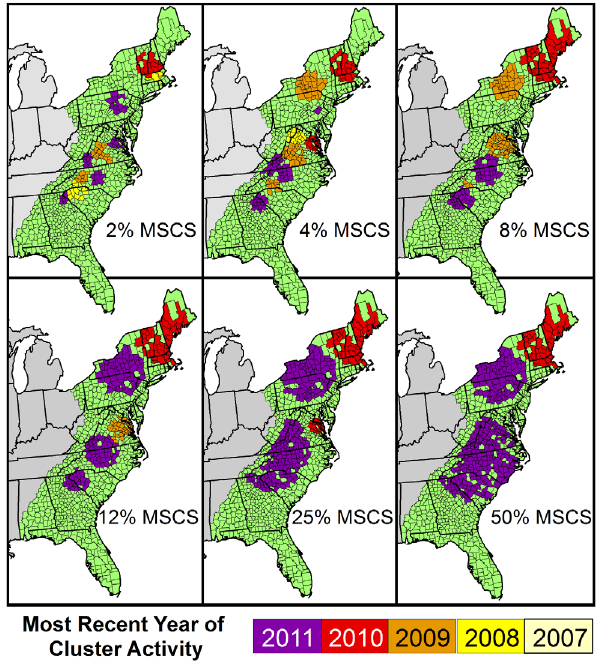
Figure 5. Clusters of High Rates of Raccoon Variant Cross Species Transmission over Varying Spatial Cluster Values, 2007–2011.